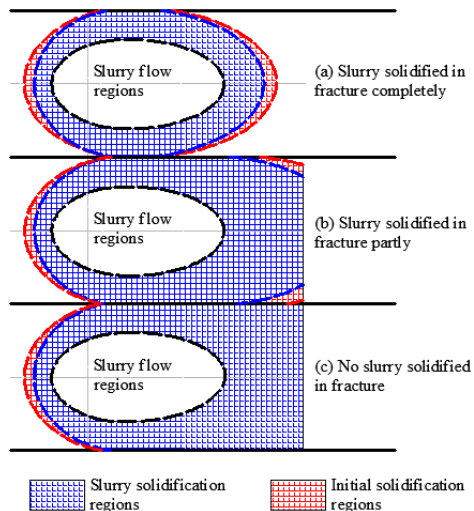
Figure 12. Schematic of the plugging process in dynamic grouting.